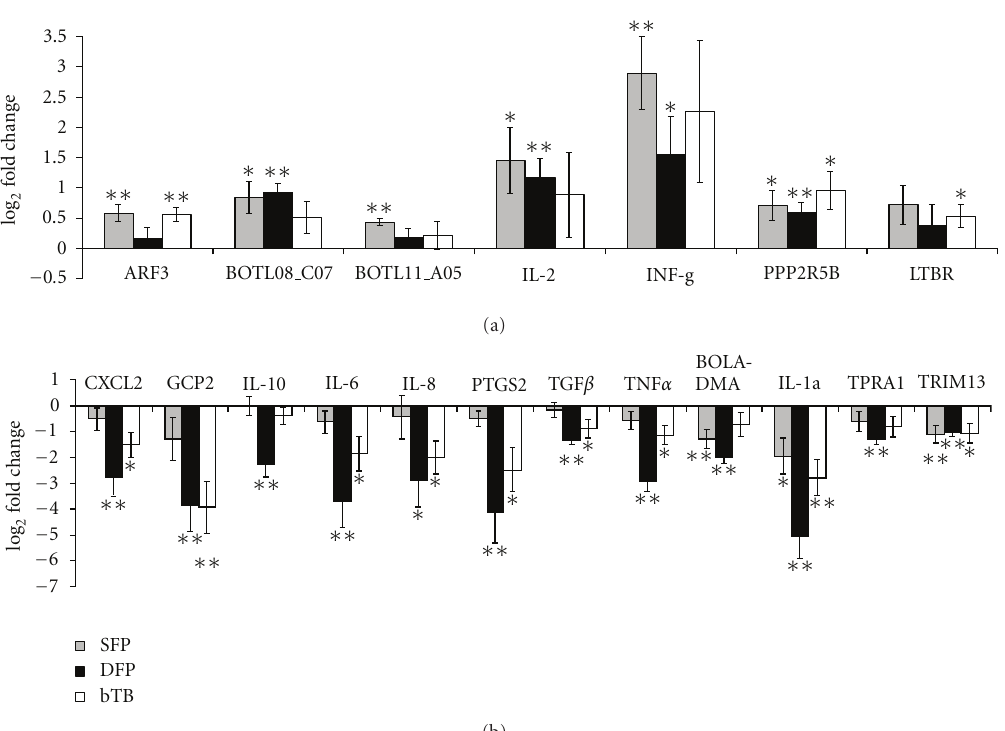
Figure 3: The relative gene expression levels compared with the reference pool of RNA from healthy cattle, as determined by qPCR assays, for the single antemortem test-false positive (SFP, shaded box), double antemortem test-false positive (DFP, solid box), and bTB-infected (bTB, clear box) groups of cattle. Gene expression levels (in log 2 fold change) were calculated using the published mathematical algorithm [37] in which the reference pool of RNA was set as baseline (0 value at Y -axis) and used as the calibrator. Statistically significant di ff erences were determined using Student’s t -test and are shown at P ≤ 0 . 05 ( ∗ ) and P ≤ 0 . 01 ( ∗∗ ). The error bars represent the standard error of the mean expression level for a group of cattle. (a) Genes with increased expression in all groups of cattle. (b) Genes with decreased expression in all groups of